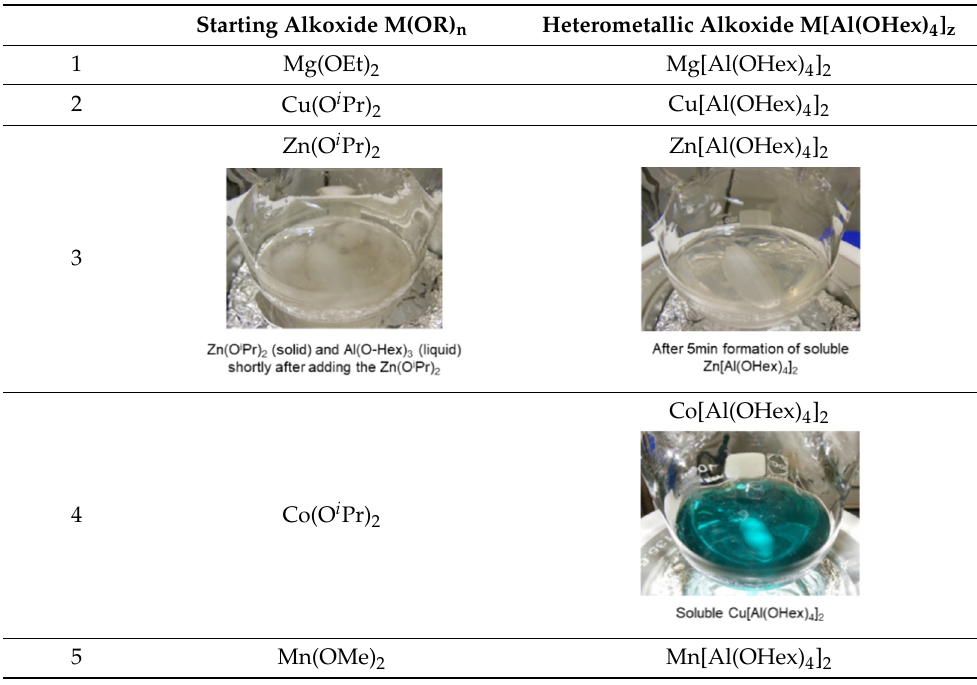
· min − 1 and n [solvent] = 300 mmol,